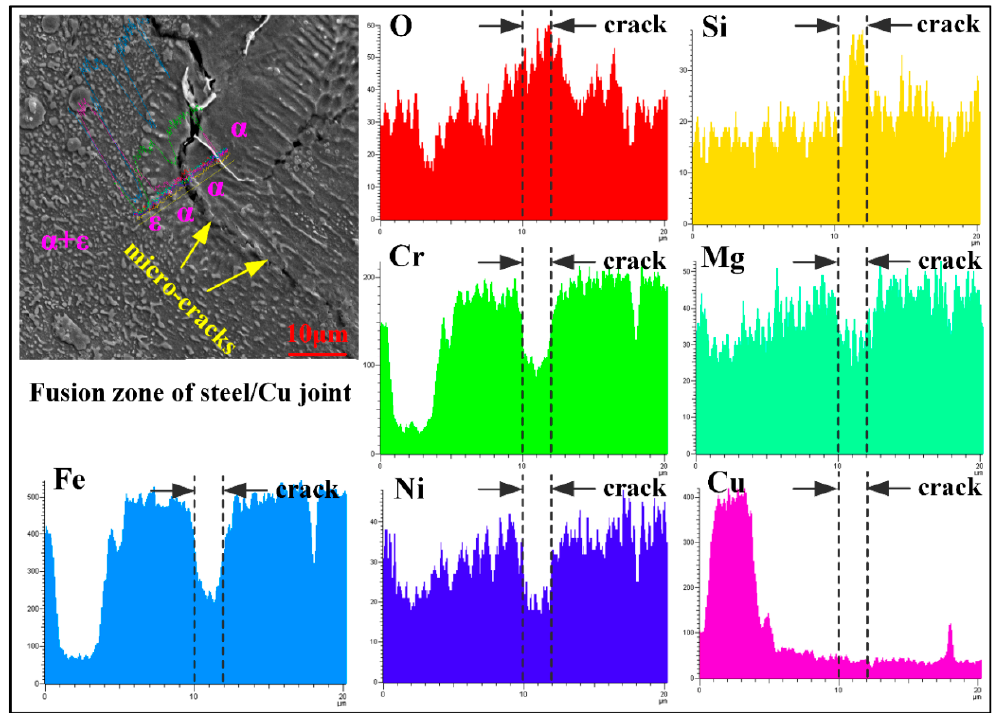
Figure 3. The element distribution of weld zones with solidification cracking.